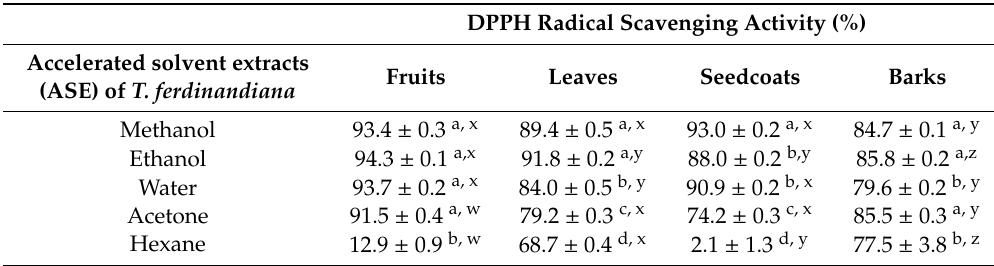
Table 2. The 2, 2-diphenyl-1-picrylhydrazyl (DPPH) radical scavenging capacity of T. ferdinandiana tissues. DPPH Radical Scavenging Activity